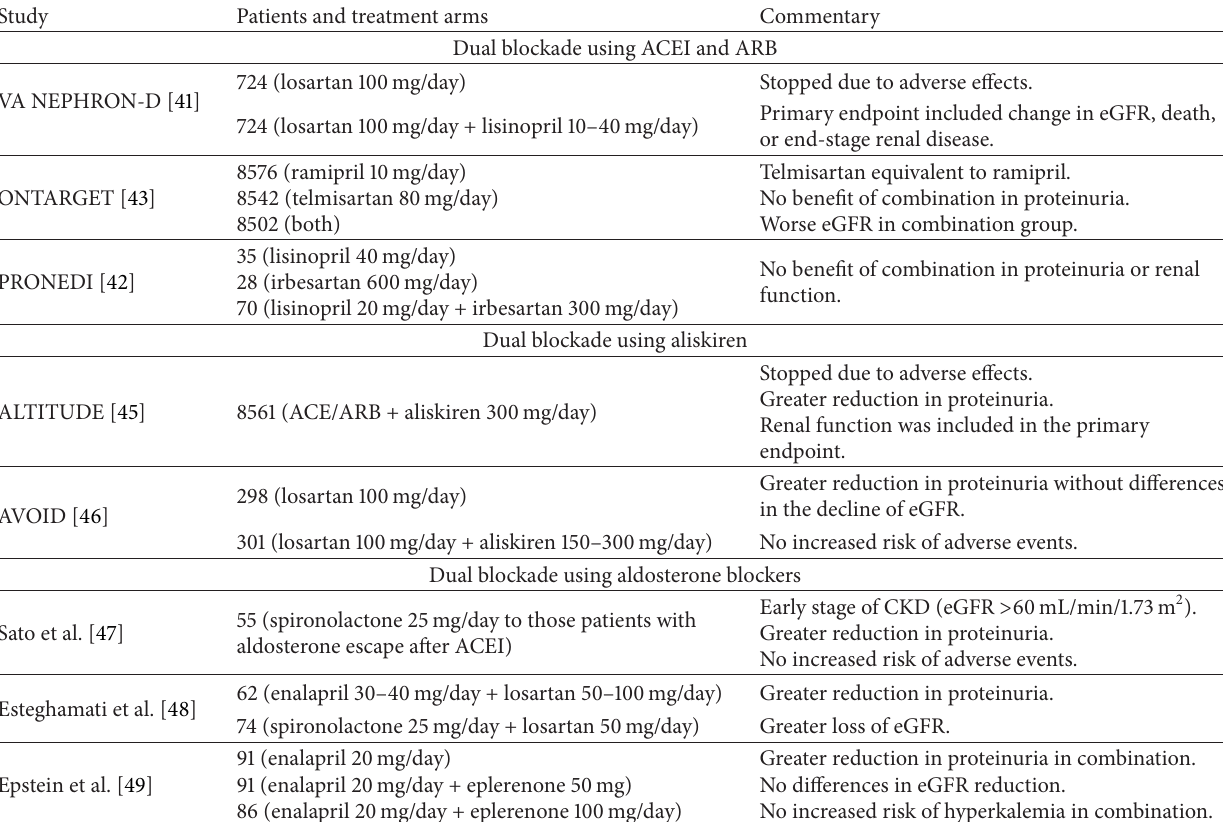
Table 1: Most relevant clinical trials assessing dual blockade of renin-angiotensin-aldosterone system in diabetic nephropathy.